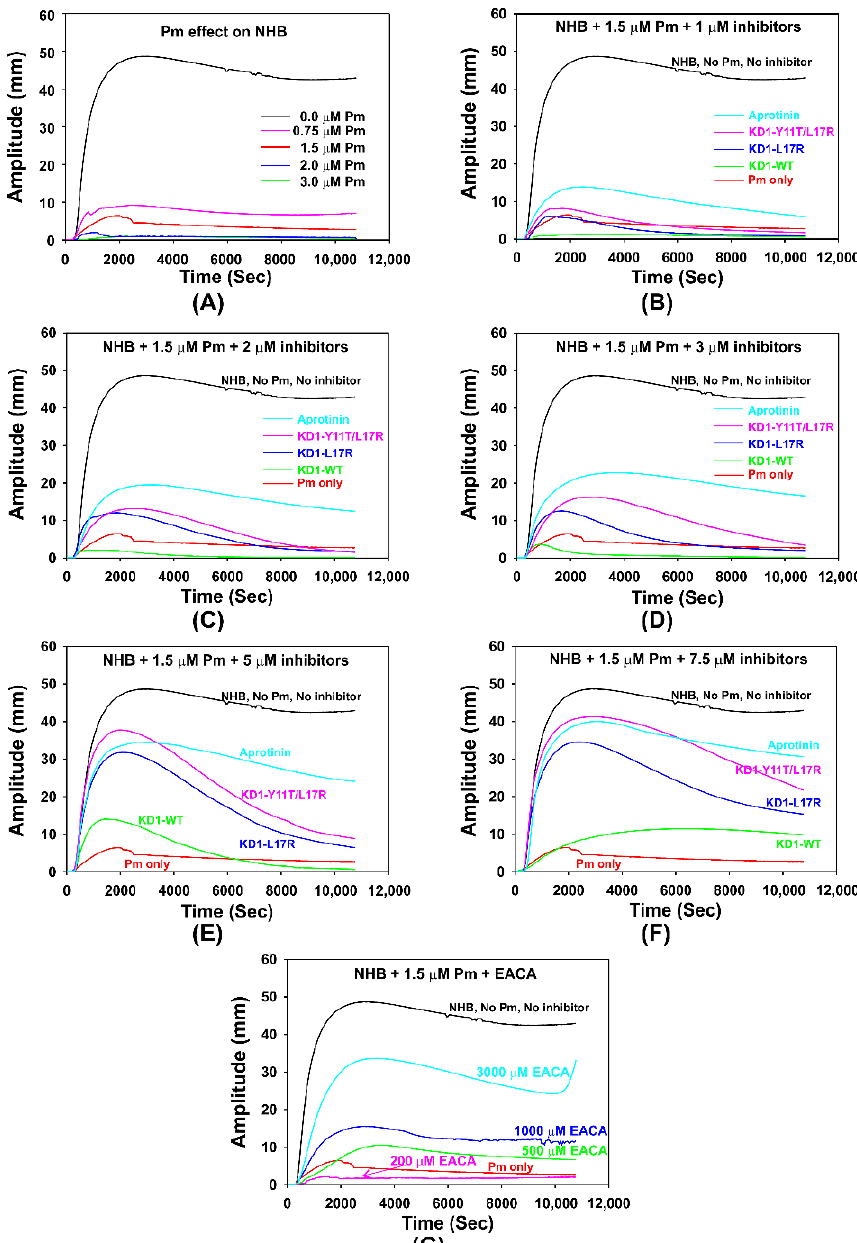
Figure 7. Thromboelastograms illustrating the dose-response analysis of KD1-WT, KD1-L17R-K COOH , KD1-Y11T / L17R-K COOH , aprotinin and EACA. All experiments contained citrated whole blood (300 µ L), 1.5 µ M plasmin and 10 mM CaCl2. The antifibrinolytic agent was added first to the blood, which was then spiked with 1.5 µ M plasmin and 10 mM CaCl 2 . The clot formation and lysis were monitored for 180 min. Control experiments were performed in the presence or absence of plasmin without any antifibrinolytic agent. ( A ) Plasmin e ff ect of clot formation and fibrinolysis. Citrated whole blood (300 µ L) was spiked with various concentrations of plasmin (0–3 µ M) and 10 mM CaCl 2 . The clot formation and lysis was monitored for 180 min. E ff ect of 1 µ M ( B ), 2 µ M ( C ), 3 µ M ( D ), 5 µ M ( E ) and 7.5 µ M ( F ) of KD1-WT, KD1-L17R-K COOH , KD1-Y11T / L17R-K COOH and aprotinin on clot formation and fibrinolysis using 1.5 µ M plasmin. ( G ) E ff ect of 200 µ M to 3000 µ M EACA on clot formation and fibrinolysis using 1.5 µ M plasmin. Pm, plasmin; NHB, Normal human